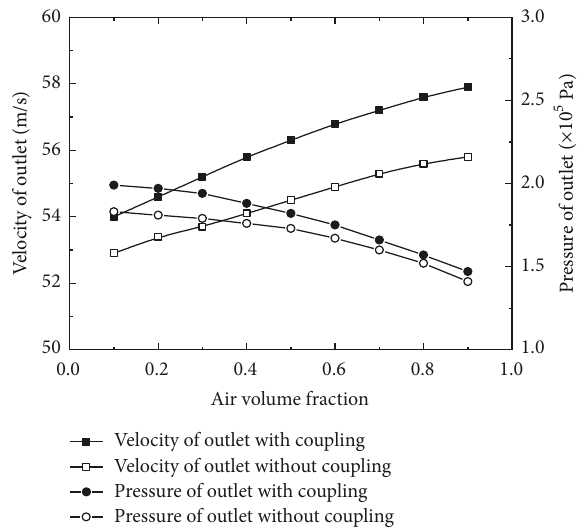
Figure 6: Effect of air volume fraction on velocity and pressure.